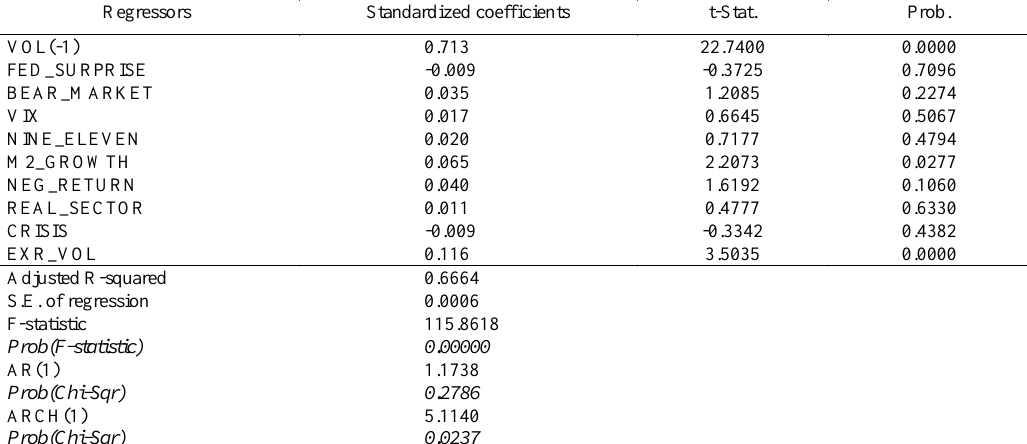
Table 1: OLS estimates of volatility of S&P 500